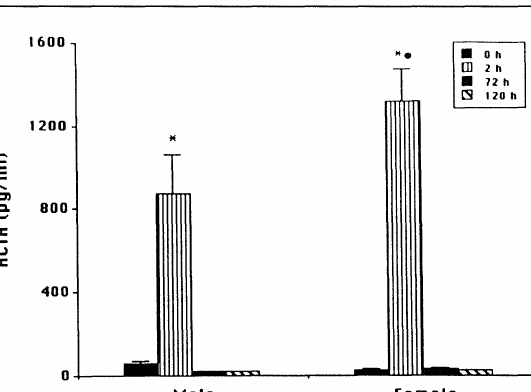
FIG. 1. Time-related effect of endotoxin (i.p., 2 mg/kg B.W.) on plasma ACTH levels in mice of both sexes. Bars represent the mean